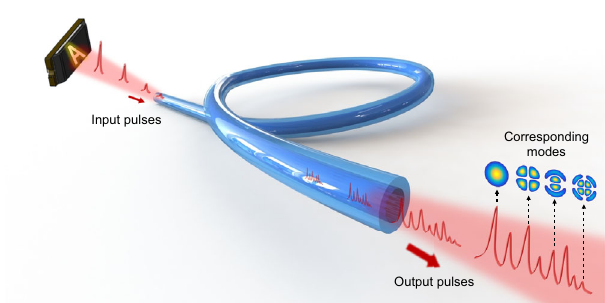
Fig. 1 Evolution of ultrashort pulses. The pulses entering the MMF will be split into lots of subpulses due to the large intermodal dispersion in the MMF. Each subpulse contains the energy of a certain mode in